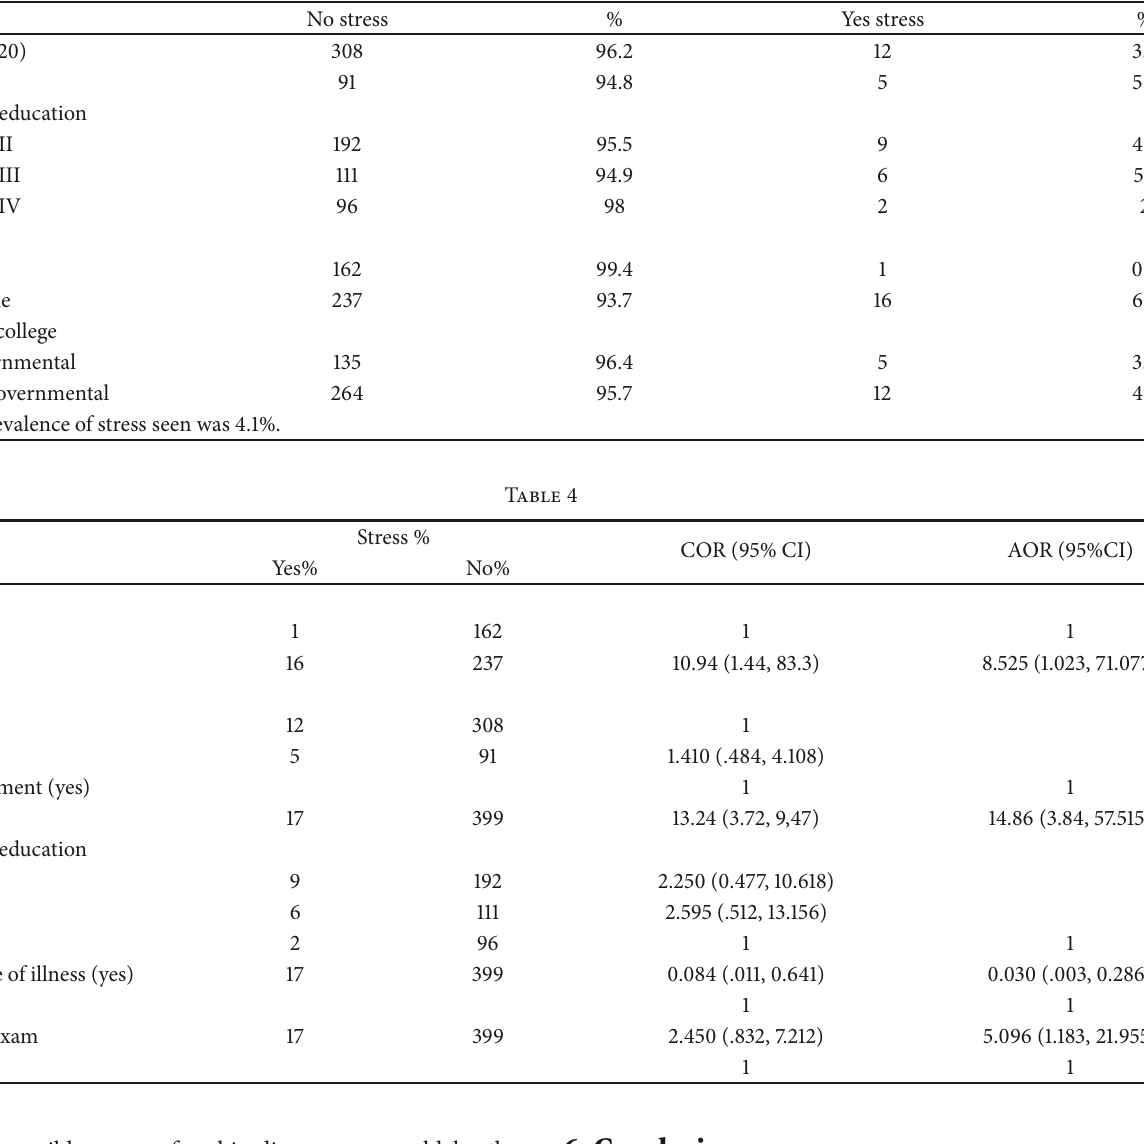
Table 3: Prevalence of stress 2016 Ethiopia